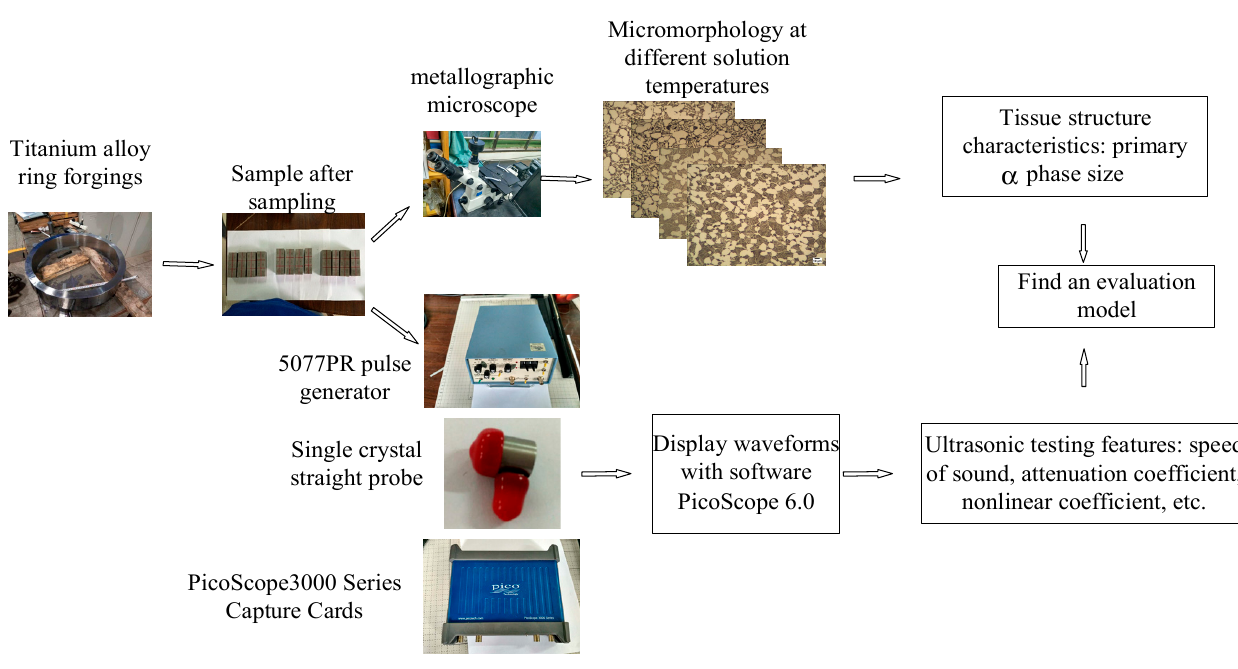
Figure 2. Process diagram of the whole experiment. TC25 experimental material contains 168 effective samples, and each sample contains five ultrasonic characteristic values (mean sound velocity, mean attenuation, primary offset, secondary offset, and nonlinear coefficient) and one primary α phase grain size value. For the 168 effective samples, the K-fold cross-validation method is used to test the model accuracy, in which K is 3, i.e., 118 effective samples are randomly selected as the training set and the remaining 50 effective samples are used as the test